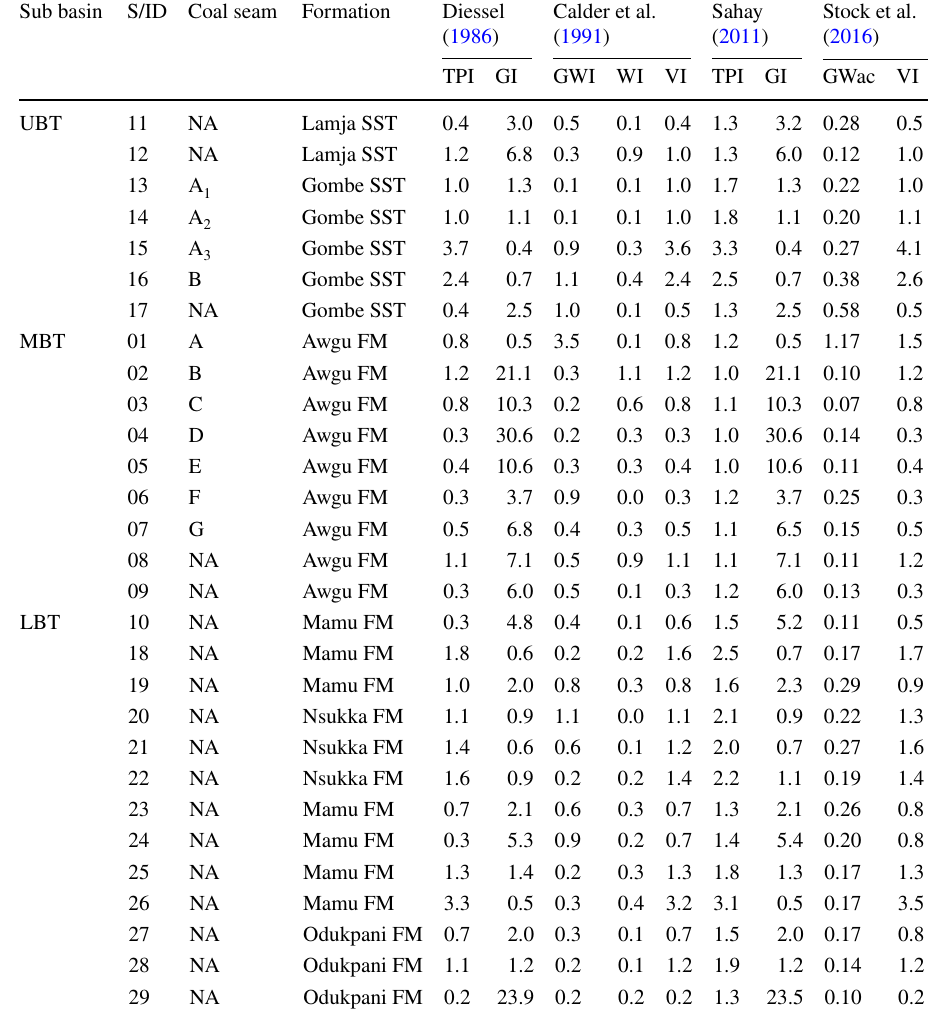
SST= Sandstone; NA= Not Applicable; FM= Formation; S/ID =